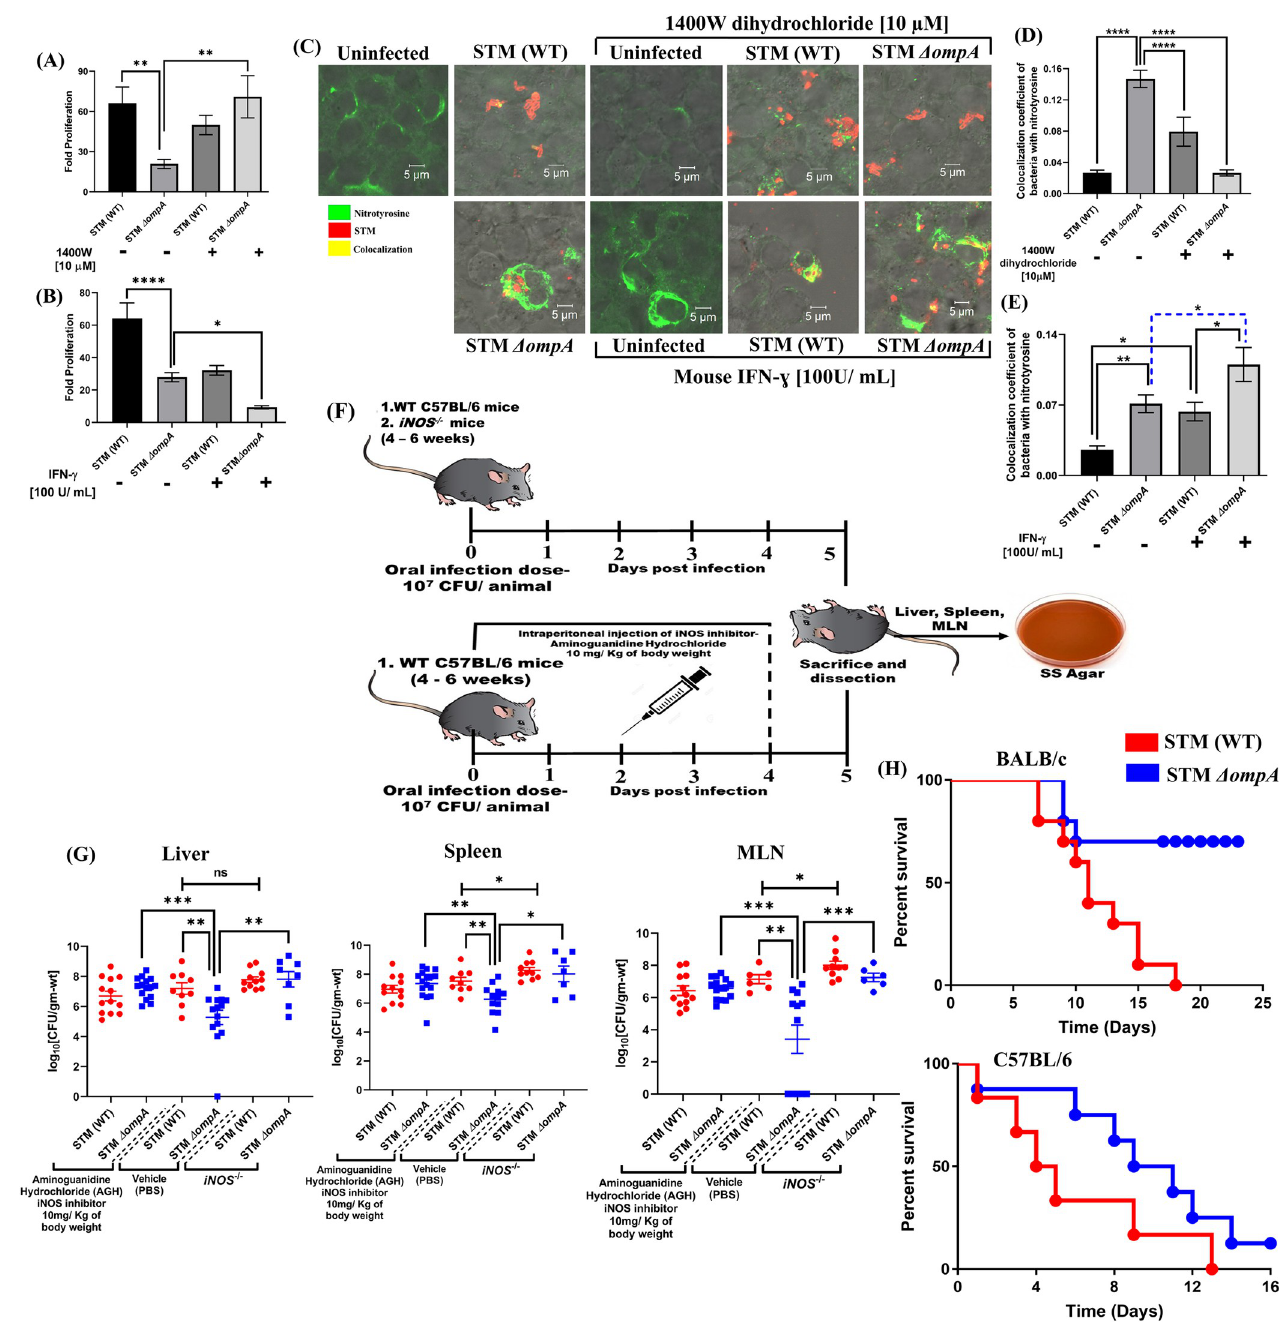
Fig 4. Modulating the activity of iNOS by using a specific inhibitor or activator determines the fate of STM Δ ompA in in vitro and in vivo infection models. Intracellular survival of STM (WT) and Δ ompA (MOI = 10) in RAW264.7 cells (16 hours post-infection) in the presence and absence of iNOS (A) inhibitor- 1400W dihydrochloride (10 μ M) and (B) activator- mouse IFN- (100U/ Ml) (n = 3, N = 3). (C) Immunofluorescence image of RAW264.7 cells infected with STM (WT) and Δ ompA (MOI = 20) in the presence and absence of (D) 1400W dihydrochloride and (E) mouse IFN-. The colocalization coefficient of bacteria with nitrotyrosine was represented in vertical bar graphs (n � 50, N = 2). (F) The schematic representation of the experimental strategy for studying the in vivo pathogenesis of STM (WT) and Δ ompA . (G) Enumerating the bacterial load in the liver, spleen, and MLN of C57BL/6 mice orally gavaged with STM (WT) and Δ ompA in the presence and absence of iNOS inhibitor aminoguanidine hydrochloride (10mg/ kg of body weight). The bacterial load from the liver, spleen, and MLN of iNOS -/- C57BL/6 mice were also quantified. The log 10 (CFU/ gm-wt.) for each CFU obtained after plating was plotted (n = 5, N = 3). (H) Studying the survival BALB/c and C57BL/6 mice infected with a lethal dose of STM (WT) and Δ ompA . The survival study was monitored till the death of all the wild-type infected mice (n = 10). Data are represented as mean ± SEM. (P) � < 0.05, (P) �� < 0.005, (P) ��� < 0.0005, (P) ���� < 0.0001, ns = non-significant, (One-way ANOVA in A, B, D, E and Mann-Whitney U test in G) .